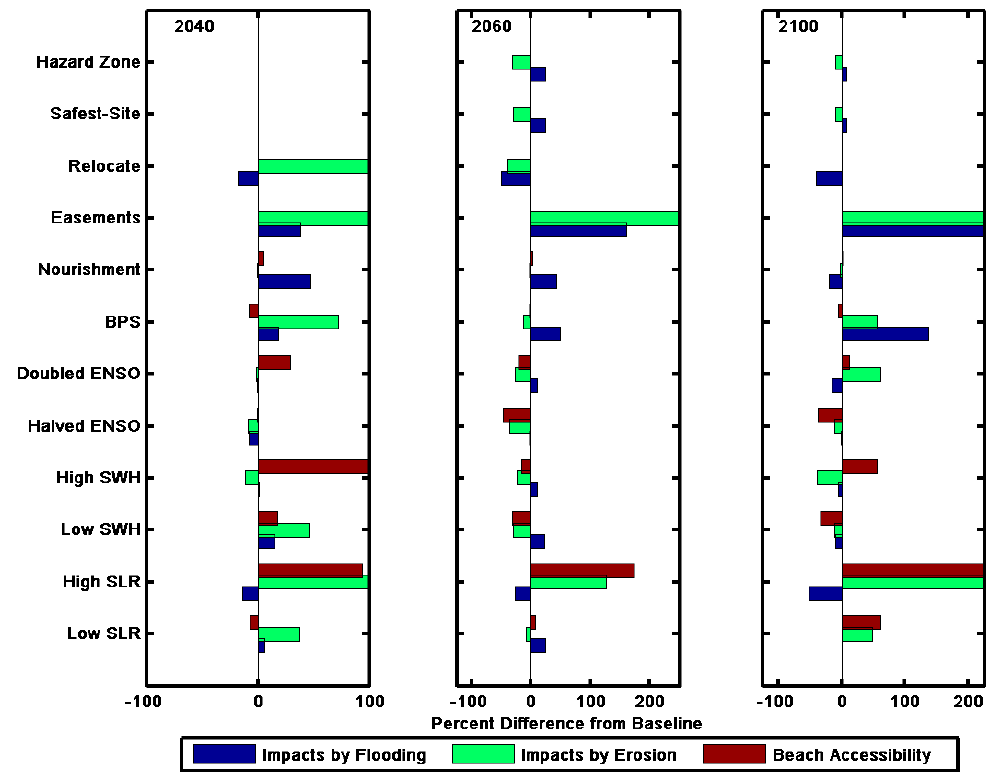
Figure 13. The percent difference in the coefficient of variance for each of the 3 metric values between each of the climate and policy drivers and the baseline scenario. Values are presented for three time periods, 2030–2040 ( left ), 2060–2070 ( middle ), and 2090–2100 ( right ).